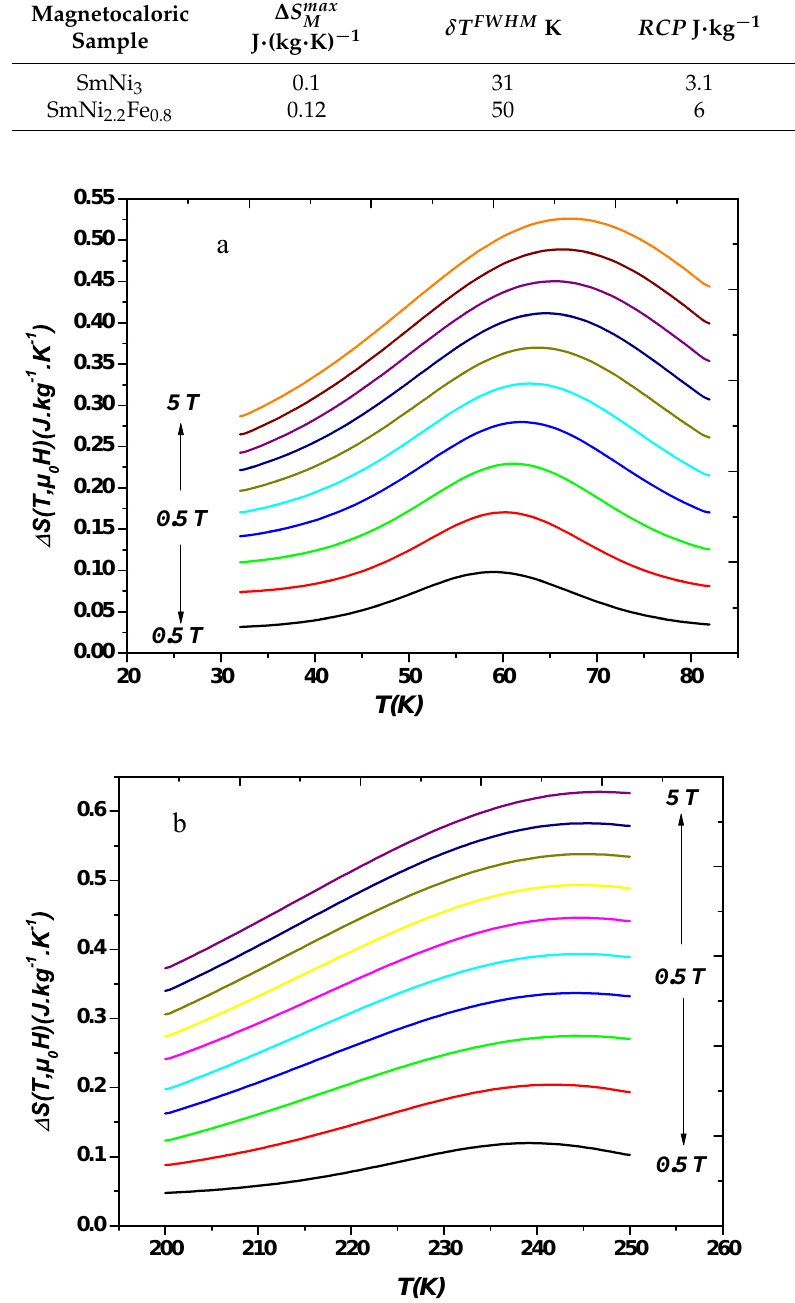
Figure 10. Modeled ∆ S M vs. temperature for the samples SmNi 3 ( a ) and SmNi 2.2 Fe 0.8 ( b ) at several magnetic